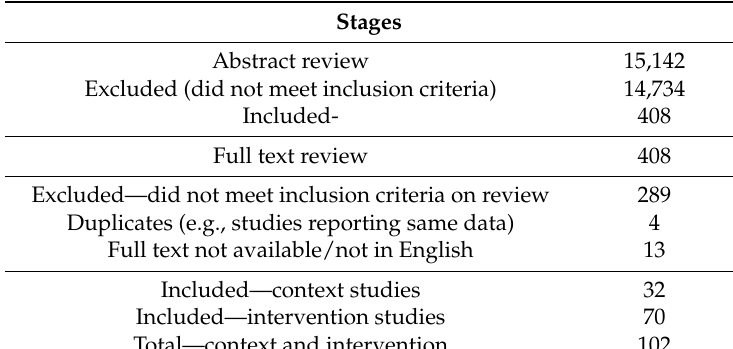
Table 2. Selection